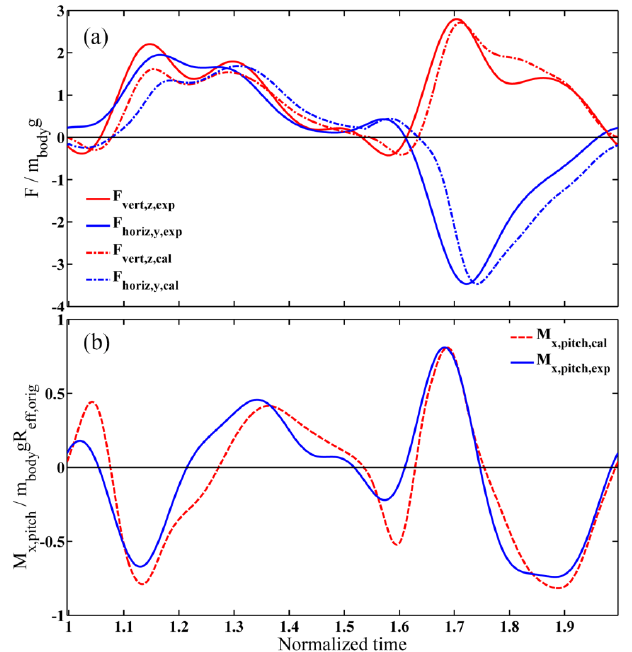
Figure 6. Comparison between calculated results (dash lines) and experimentally measured results (solid lines). Normalized time history of normalized forces ( a ); and pitch torques ( b ). The black horizontal lines denote the zero value.